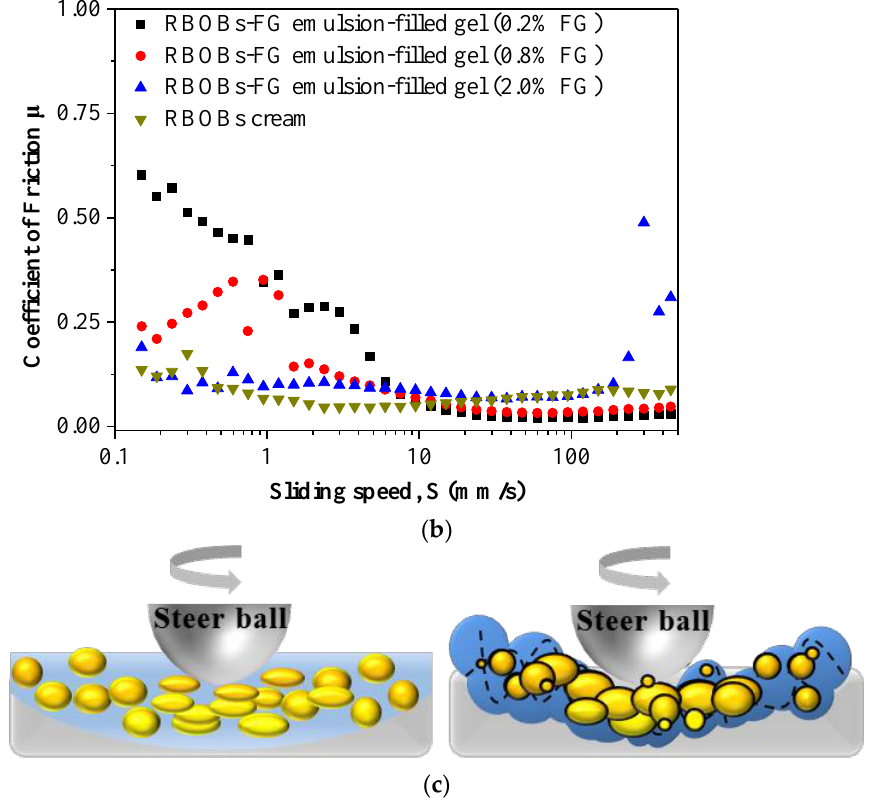
Figure 8. Tribology of FG gel matrix and pure water ( a ), RBOB cream and RBOB-FG emulsion-filled gels ( b ), lubrication mechanism for RBOB cream in a mixed regime, and lubrication mechanism for RBOB-FG emulsion-filled gels in a boundary regime ( c ). Droplets are represented by yellow spheres, the continuous phase is represented by blue color, balls and disks are represented in grey, and the FG gel network is represented by black curved lines.